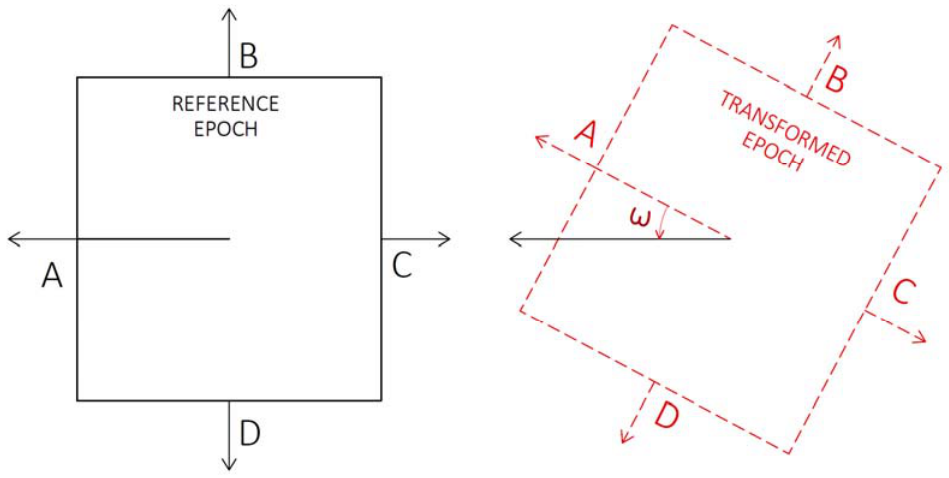
Figure 4. The schematic illustration of the normal vector